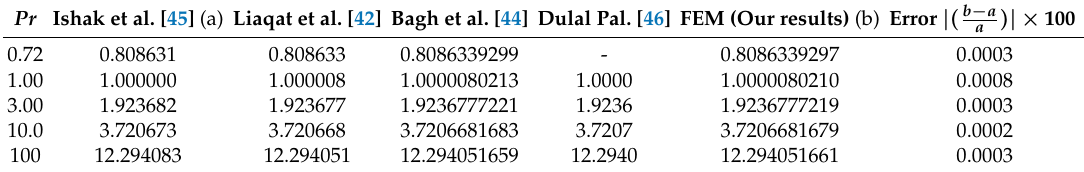
Table 3. Comparison of − ˜ θ (cid:48) ( 0 ) for various values of Pr when Pr = M = λ 1 = 1, S 1 = 0.2, Le = 1,